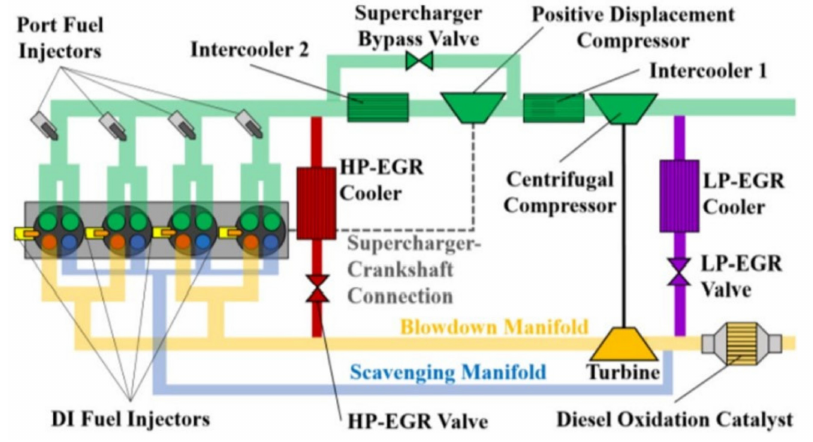
Figure 12. DEP system configuration